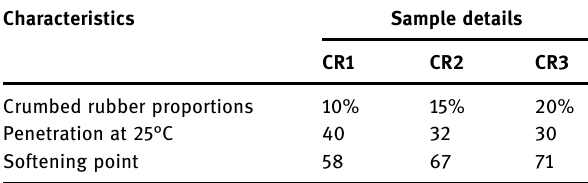
Table 3: Samples details and characteristics